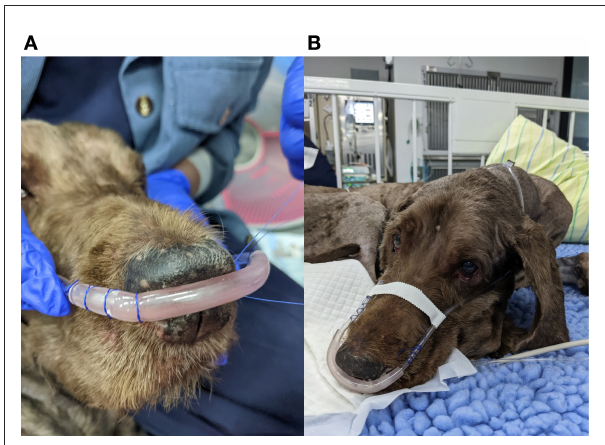
FIGURE3 Nasal prongs often need to be secured with sutures at the margins of the nares (A) . Taping over the muzzle keeps the interface in place in dolichocephalic breeds (B)